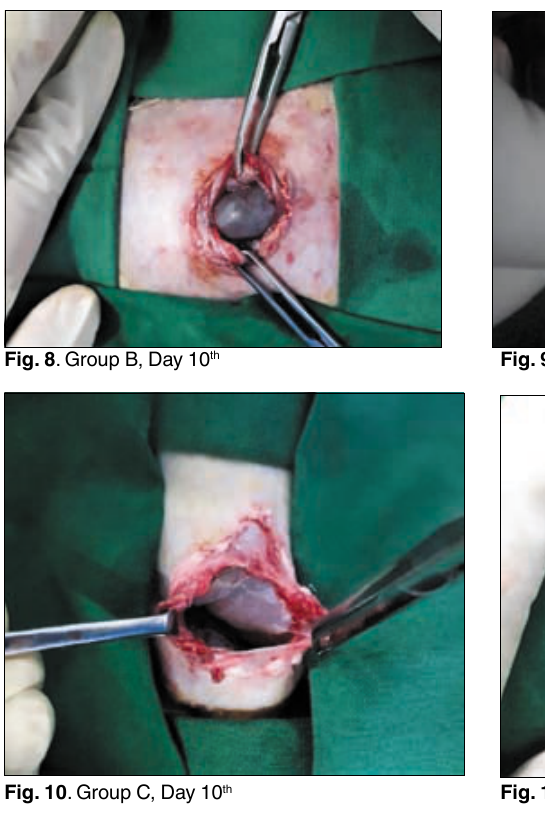
Table 3 . Adhesion score in different groups at different intervals (Mean ± SE) n=6 Groups